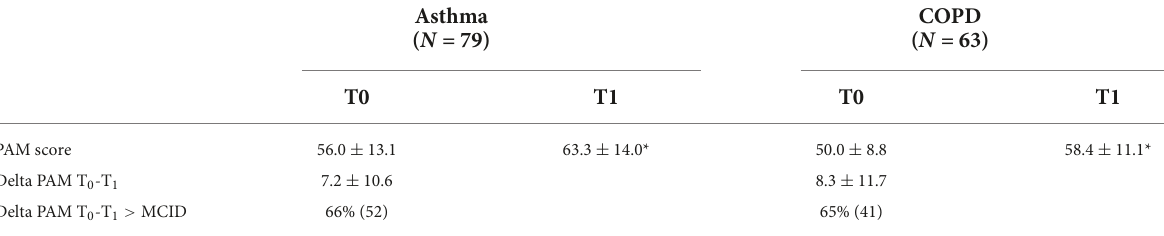
TABLE 2 PAM scores at baseline (T 0 ) and after the intervention (T 1 ) for patients whom completed both